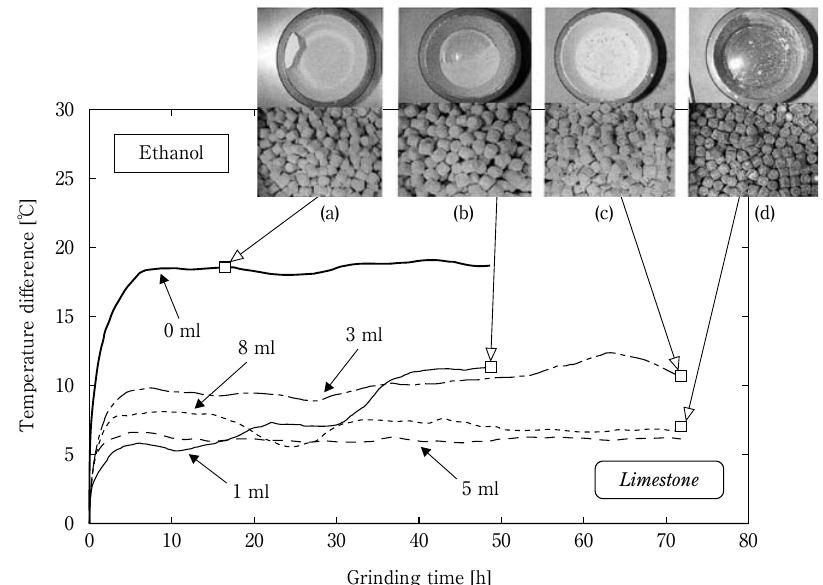
Fig. 9 Variations of the temperature and status in grinding pot as a function of grinding time with different amount of ethanol.